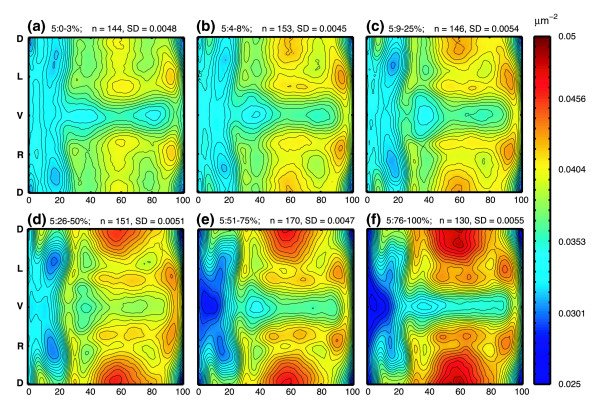
Changing local nuclear density patterns during stage 5. Average local nuclear densities on the blastoderm surface were computed for PointCloud data derived from embryos for six consecutive time intervals spanning stage 5. (a-f) Cylindrical projections of the average for each of these temporal cohorts. The range of membrane invagination for embryos in each temporal cohort is shown above each panel (for example, 5:0-3%). Isodensity contours were plotted over a color map representing local average densities from 0.025 nuclei/μm2 (dark blue) to 0.05 nuclei/μm2 (dark red). The position on the y-axis of the dorsal midline (D), ventral midline (V), and left (L) and right (R) lateral midlines are indicated. On the x-axis, anterior is to the left, posterior is to the right, and the distance along the a/p axis is given as a percent egg length. The number of embryos in each cohort (n) and the standard deviation of nuclear density values (SD) are also shown. It can be seen that over time the local nuclear densities increased dorsally, decreased at the poles, and changed little ventrally.